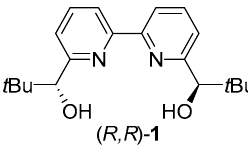
Figure 2. Bolm’s ligand ( R,R )- 1 .